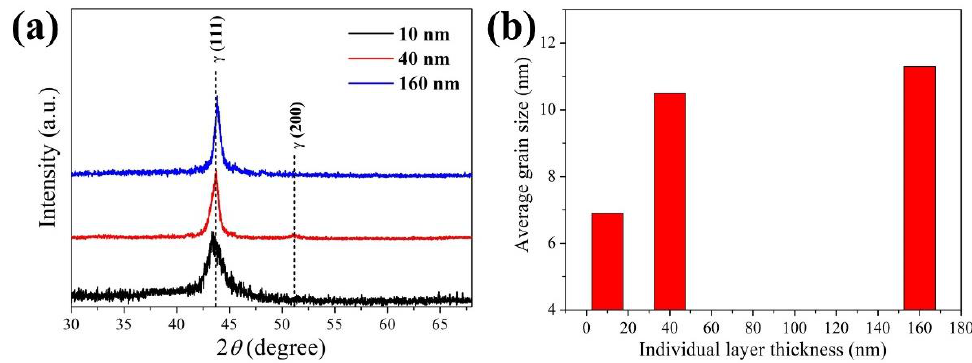
Figure 3. ( a ) XRD results of Ni/Ni 3 Al-MoW multilayers and ( b ) average grain sizes calculated by Debye–Scherrer’s equation with h = 10 nm, 40 nm, and 160 nm.